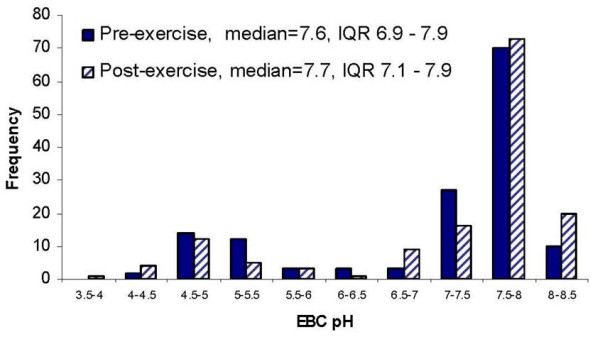
Distribution of pre- and post-exercise breath pH values in runners. In this group of adolescent runners, there was no significant difference between pre- and post-exercise breath pH (p = 0.63 for nonparametric test of difference in pre- and post-exercise breath pH distributions).